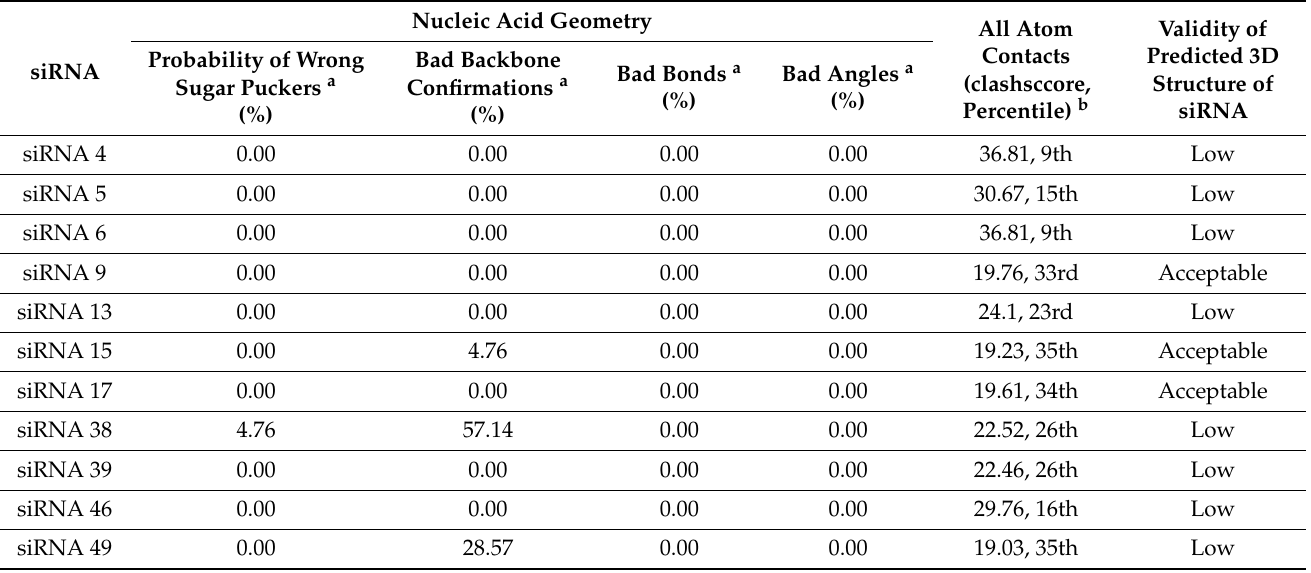
Table 4. Validation scores for the predicted 3D structures of the 11 non-immunogenic siRNA candidates.